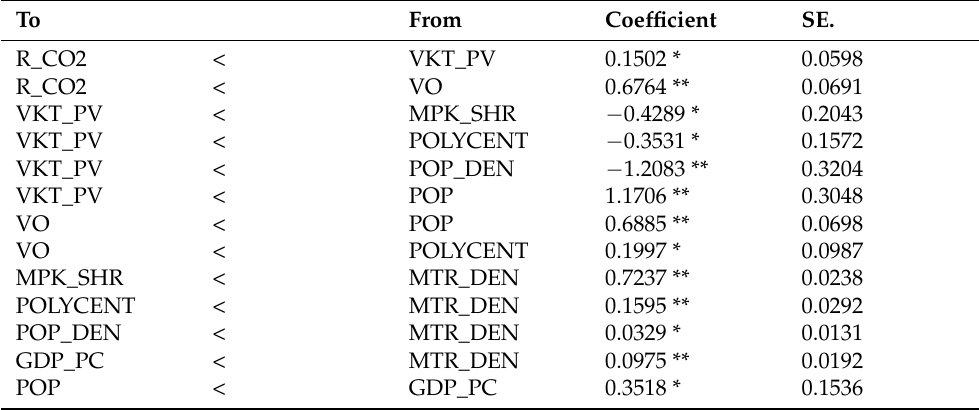
Table 4. Detailed path-specific elasticity estimates.